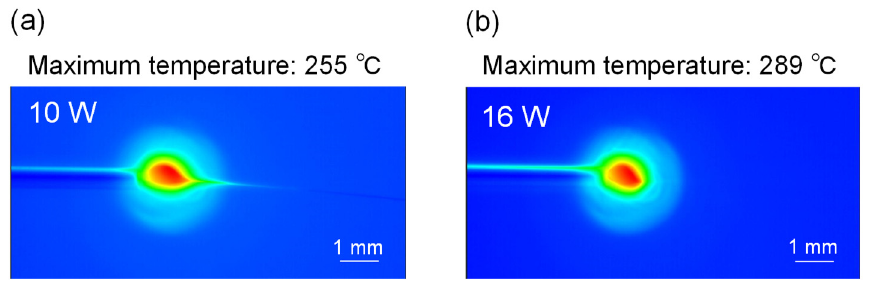
Figure 5. Infrared images of PLLA fibers near the nozzle during LES at laser powers of ( a ) 10 and ( b ) 16 W.